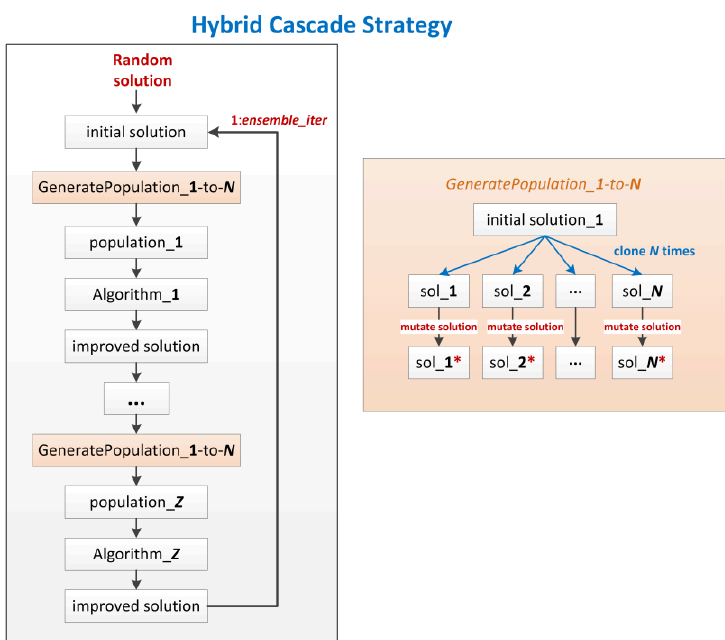
Figure 4. Hybrid cascade strategy. For each iteration of the ensemble, the initial population is generated from the improved solution of the previous iteration. Starting from this solution, a new population sol_i*, i=1..N, is generated by applying a mutation operator to clones sol_i, i=1..N of the previously-improved solution.